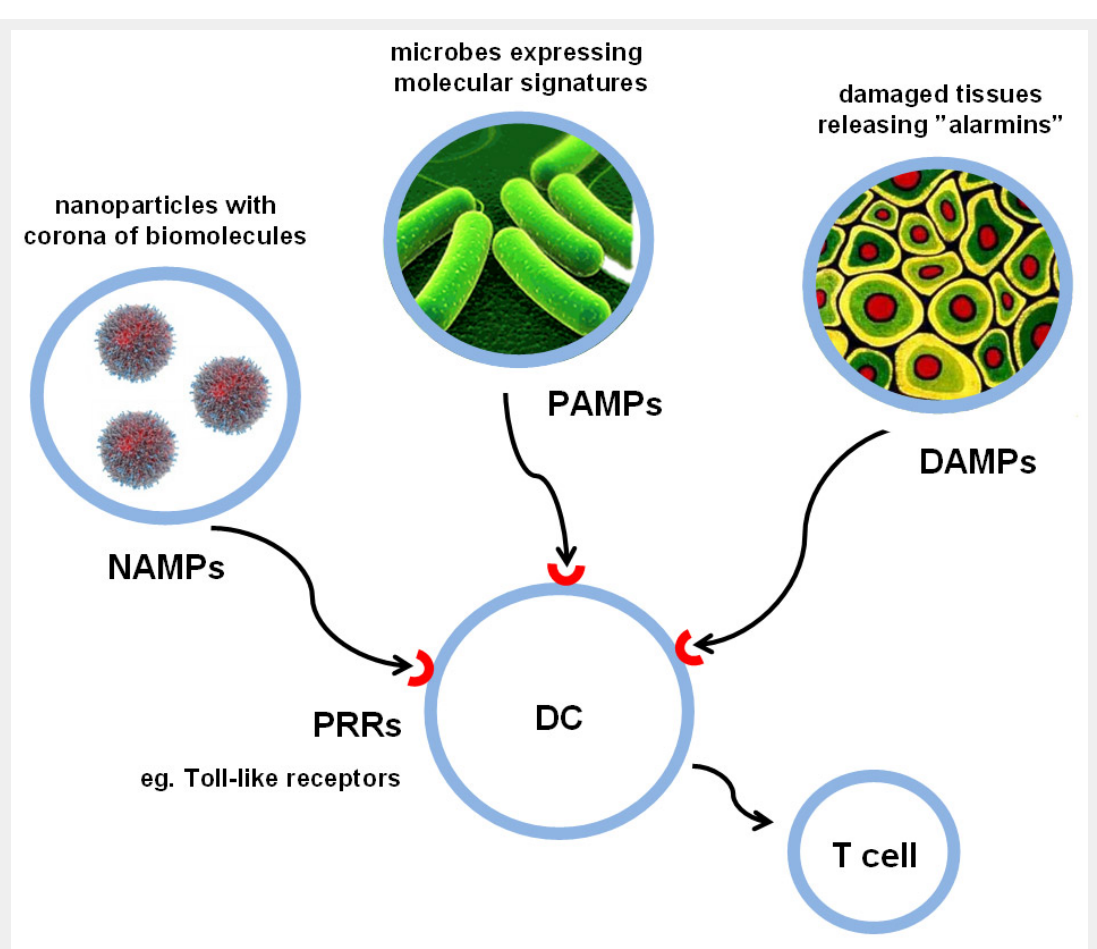
Do nanoparticles act as danger signals and/or display such signals on their surface? In this hypothetical diagram, the analogy is made between pathogens (microorganisms) that display pathogen-associated molecular patterns (PAMPs) and damaged or stressed tissues that release damage-associated molecular patterns (DAMPs), such as HMGB1, a non-histone nuclear protein that acts as a secreted alarmin, and engineered nanoparticles that are coated with a bio-corona of proteins, possibly unfolded, thereby revealing hidden epitopes, that may act as nanomaterial-associated molecular patterns (NAMPs). These molecular signatures are recognised by so-called pattern recognition receptors or PRRs – including the Toll-like receptors – on the surface of innate immune cells or expressed within such cells. The activation of PRRs triggers inflammation and alerts the adaptive immune system to impending danger